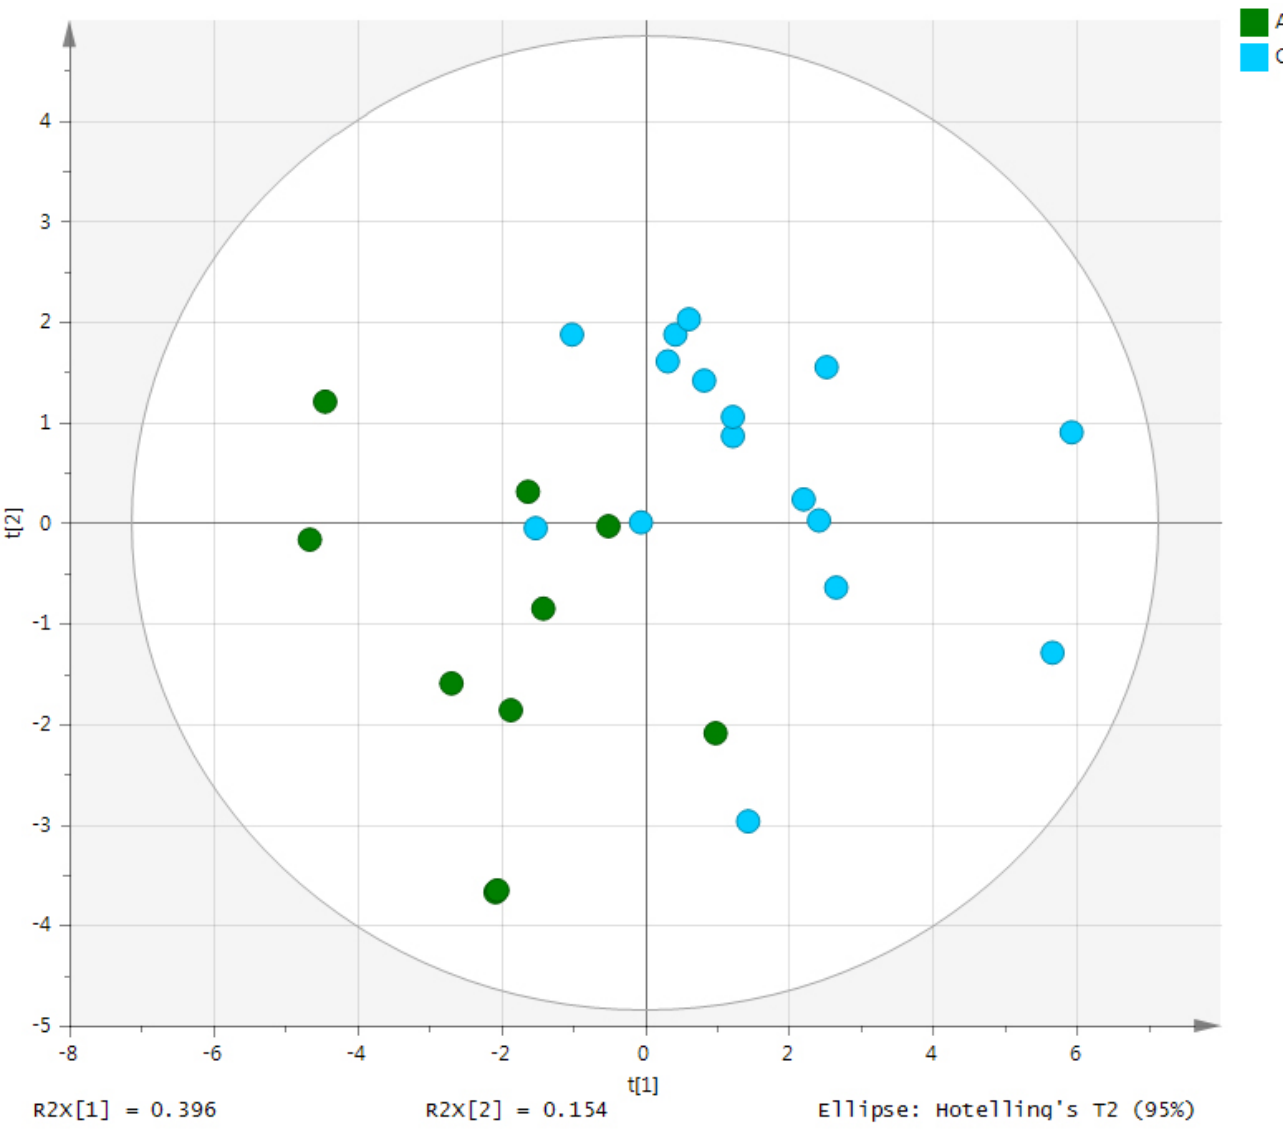
Figure 2. OPLS-DA score plot derived from the 1H-NMR spectra of serum from the ulcerative colitis (UC) patient group ( n = 10) and healthy control (HC) group ( n = 10). OPLS-DA, orthogonal partial least-squares discriminant analysis; NMR, nuclear magnetic resonance; A2, ulcerative colitis patient group; C2, healthy control group.